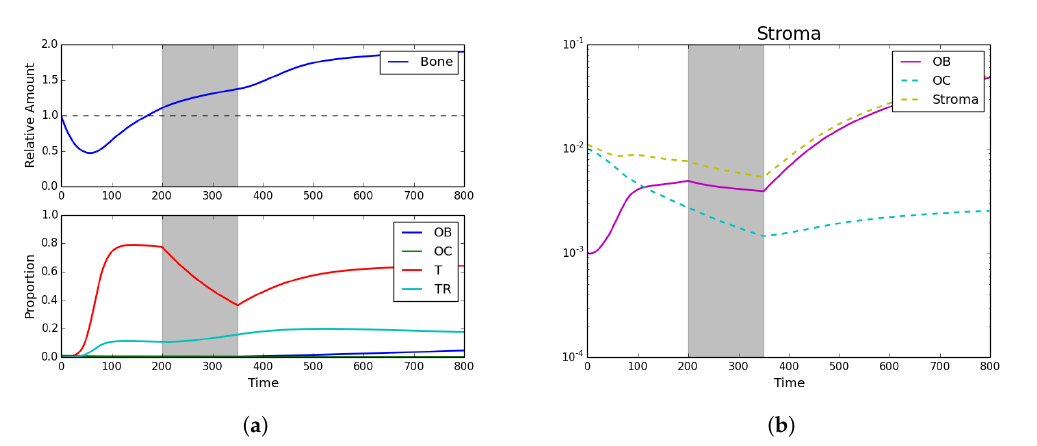
Figure 3. Standard chemotherapy. ( a ) Bone size and strategy density; ( b ) stroma. Here we see the impact of standard chemotherapy regimens that decrease the PCa-susceptible population and increase the PCa-resistant population. Assuming initial densities of the different population as follows: ρ OB ( 0 ) = 0.001, ( 0 ) = 0.0, and B ( 0 ) = ρ OC ( 0 ) = 0.01, ρ T ( 0 ) = ρ T R